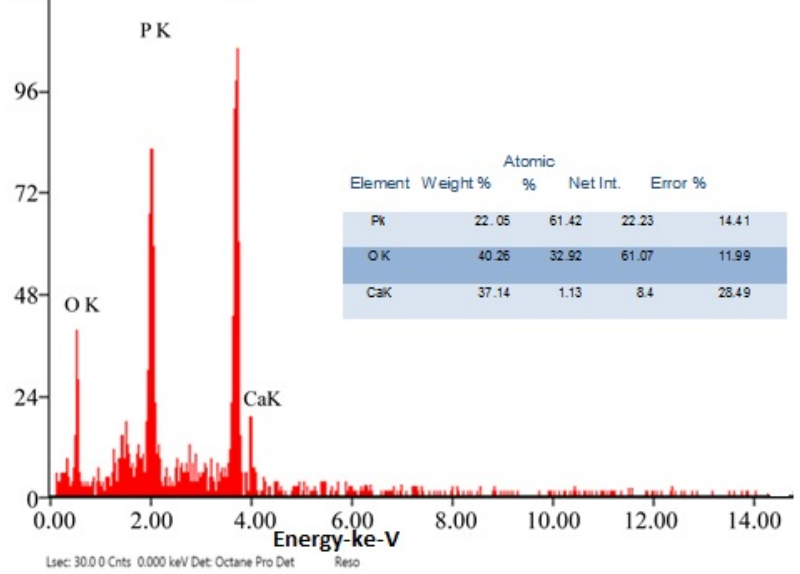
Figure 7. EDX analysis of HAPNPs powder.